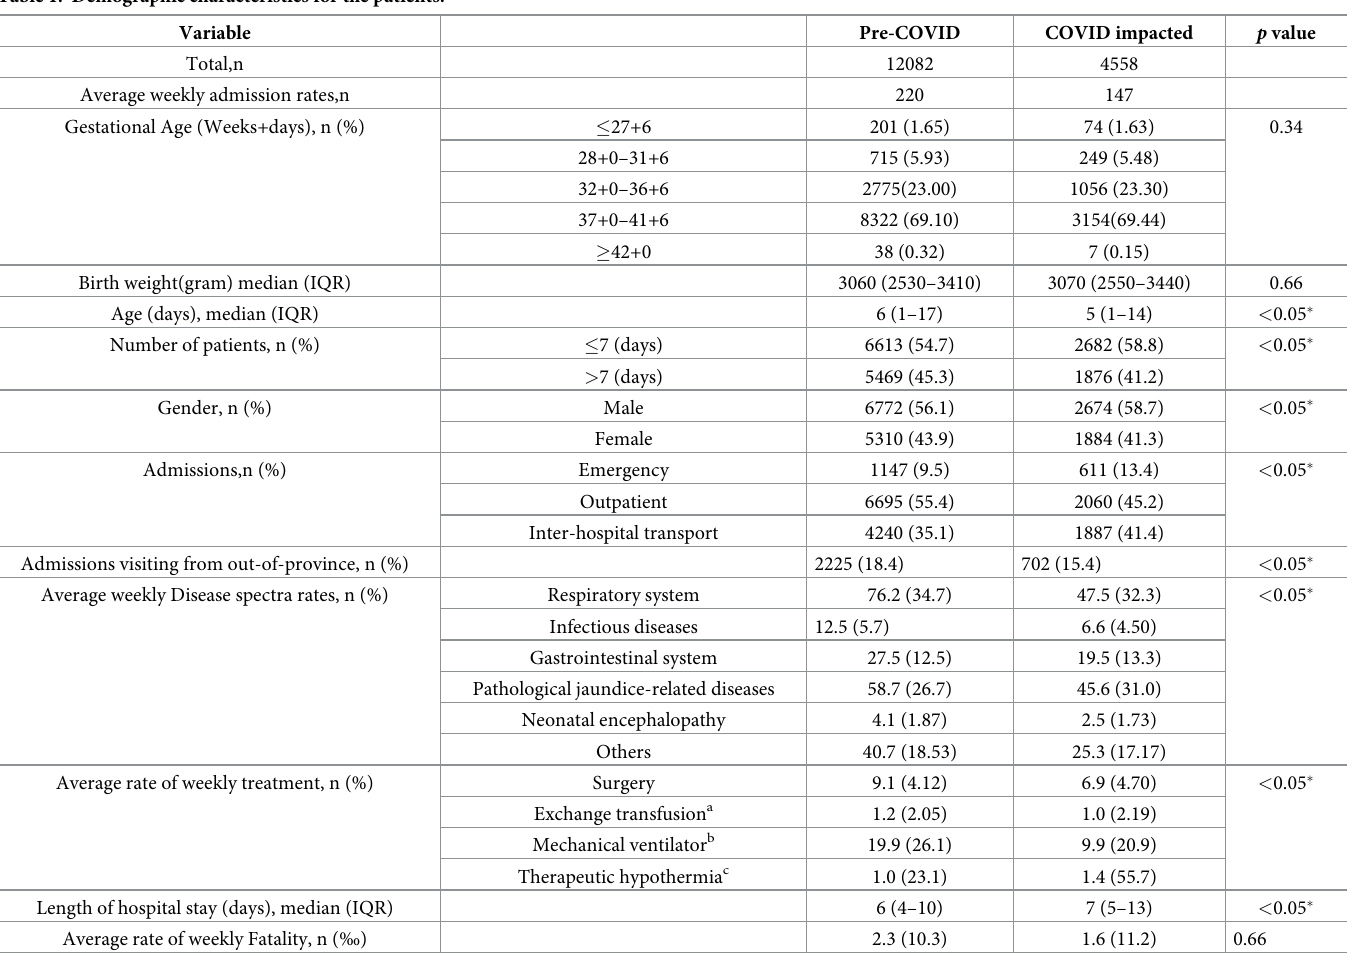
Table 1. Demographic characteristics for the